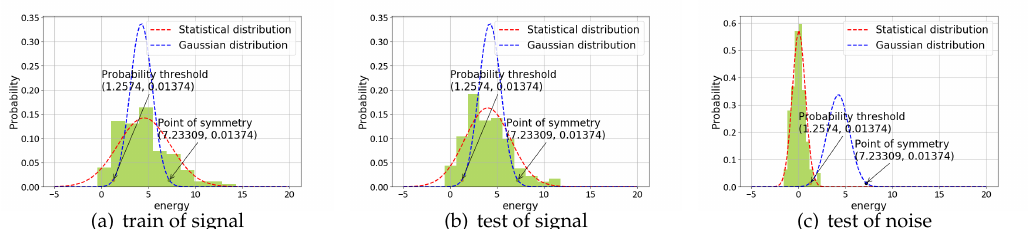
Figure 8. The probability distribution of the average value of the signal. From ( a ) to ( c ), the subgraphs are the train set data distribution, the seismic test set distribution, and the noise test set distribution of the energy mean feature. The red dotted line represents the statistical distribution, while the blue dotted line is distribution obtained by the Gaussian process using prior information.